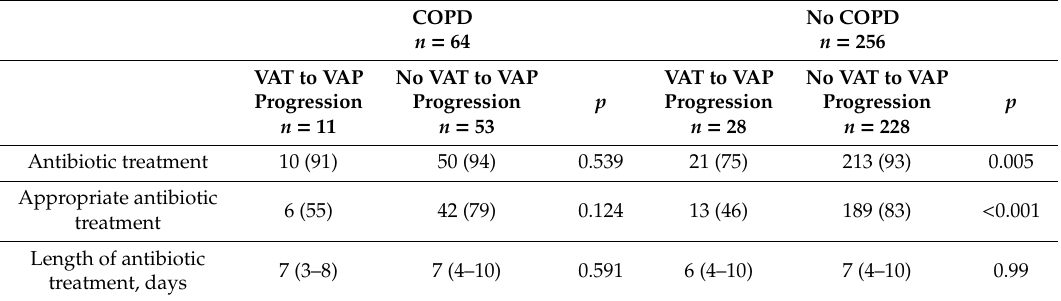
Table 4. Antibiotic use in COPD and non-COPD patients with ventilator-associated tracheobronchitis.